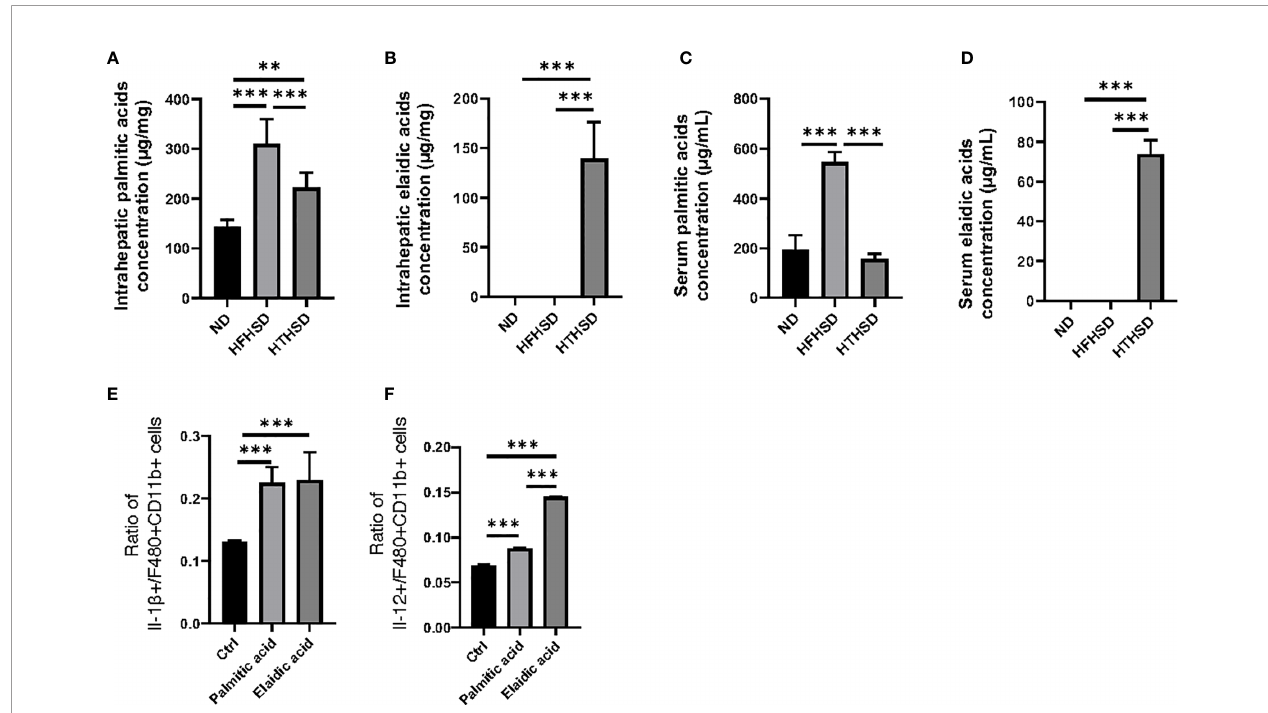
FIGURE 4 | The effect of elaidic acid on IL-1 b secretion from macrophages was comparable to that of palmitic acid, and the effect of elaidic acid on IL-12 secretion was signi fi cantly stronger. (A) Intrahepatic palmitic acid concentration ( m g/mg) (n=6). (B) Intrahepatic elaidic acid concentration ( m g/mg) (n=6). (C) Serum palmitic acid concentration ( m g/mL) (n=6). (D) Serum elaidic acid concentration ( m g/mL) (n=6). Data are represented as mean ± SD; **p < 0.01, ***p < 0.001 using one-way ANOVA and an unpaired, two-tailed Student ’ s t